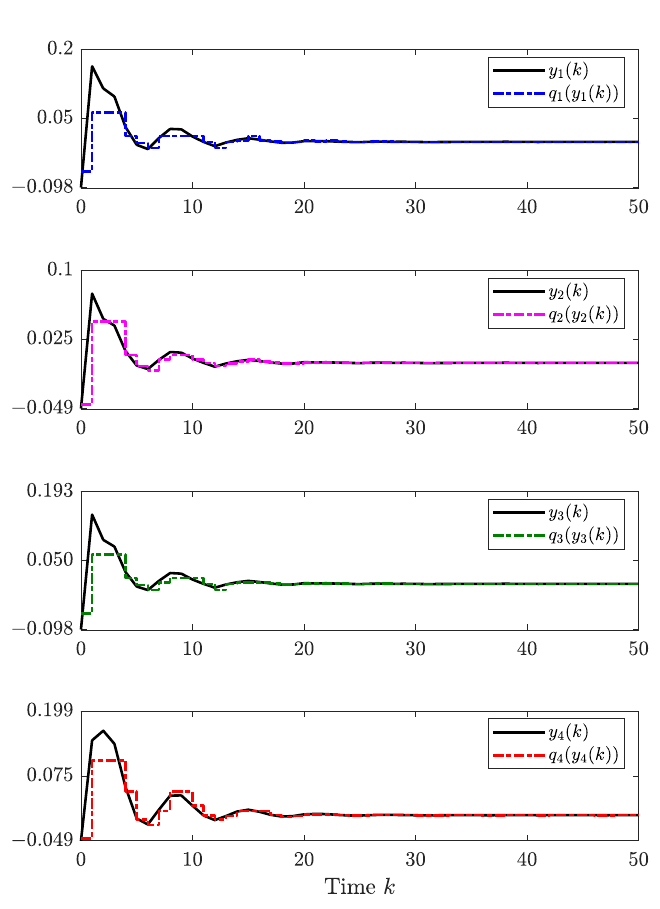
Figure 3. Measurement and quantized measurement of sensor i in Case 2, i = 1,2,3,4.